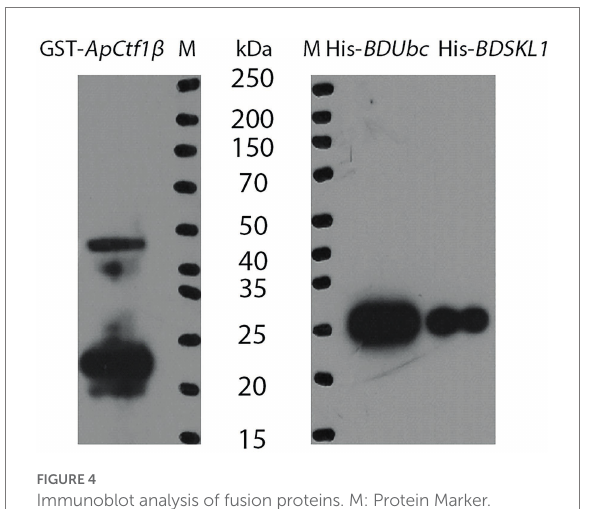
FIGURE 4 Immunoblot analysis of fusion proteins. M: Protein Marker.